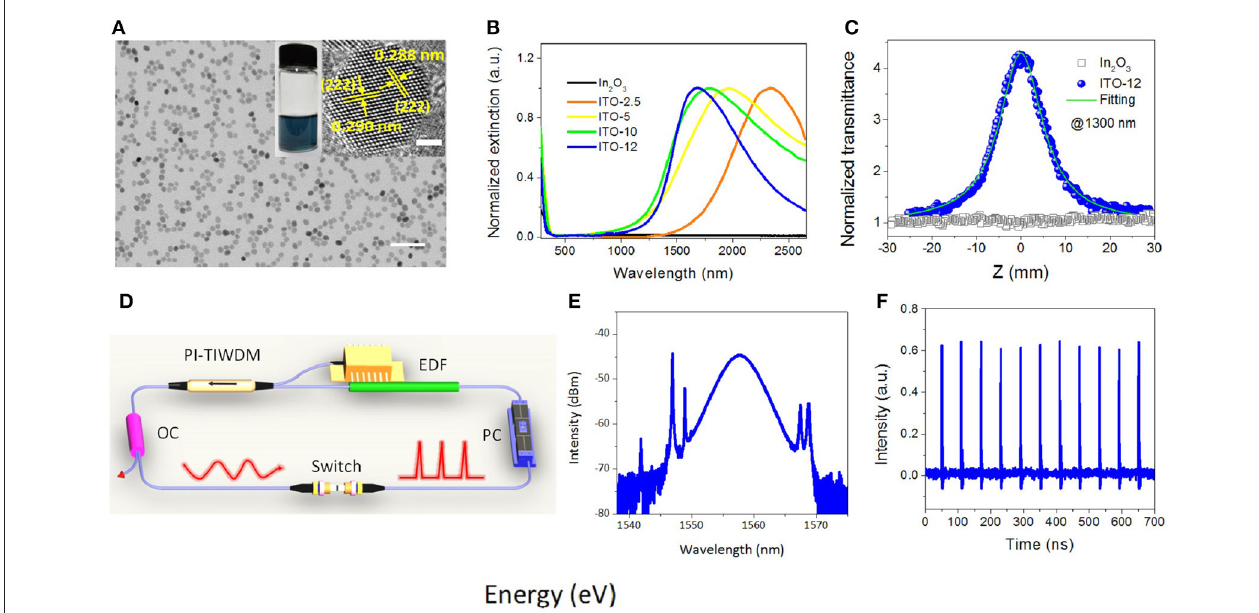
FIGURE 2 | (A) Typical TEM images of colloidal ITO NPs, with an average diameter of ca. 9nm. The Inset shows a photograph of the colloidal solution of ITO NPs and a high resolution TEM image of a single ITO NP. (B) Normalized absorption spectra of colloidal dispersions of ITO NPs doped with 0–12% SnO 2 (denoted as In 2 O 3 , ITO-2.5, ITO-5, ITO-10, and ITO-12). (C) Z-scan trace of a PVA film containing ITO NPs recorded at 1.3 µ m. ITO-12 shows notable saturable absorption, as compared to the undoped In 2 O 3 . (D) Setup of an EDF laser for mode-locking pulse generation (OC: output coupler; EDF: Er-doped fiber; PI-TIWDM: polarization-independent tap-isolator-wavelength-division multiplexer). (E) Mode-locked pulse laser spectrum. (F) Mode-locked pulse train, giving a repetition rate of 16.62